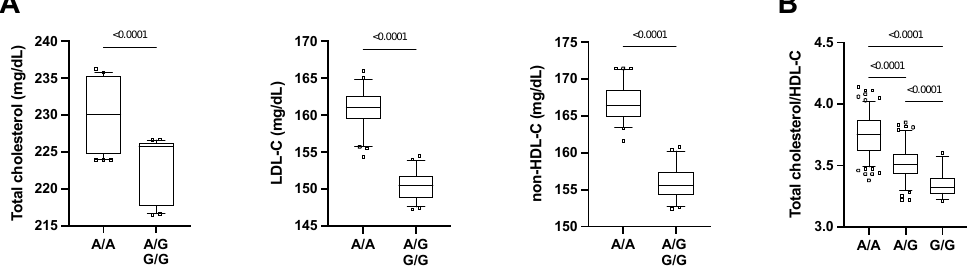
Figure 2. Blood lipid parameters, adjusted for age and gender, according to rs3746444 (MYH7B miR-499) genotypes in ( A ) 125 subjects with moderate dyslipidemia and not on lipid-lowering therapy and (A/A, n = 64; A/G + G/G, n = 52) ( B ) in 302 patients affected by dyslipidemia and treated with lipid-lowering therapy (A/A, n = 158; A/G, n = 116; G/G, n = 28). Whiskers of the boxplots mark the 5th and 95th percentiles, the boxes 25th percentile, median and 75th percentile, while extreme values are shown by circles. p -values for Tukey’s post-hoc comparisons following one-way ANCOVA.